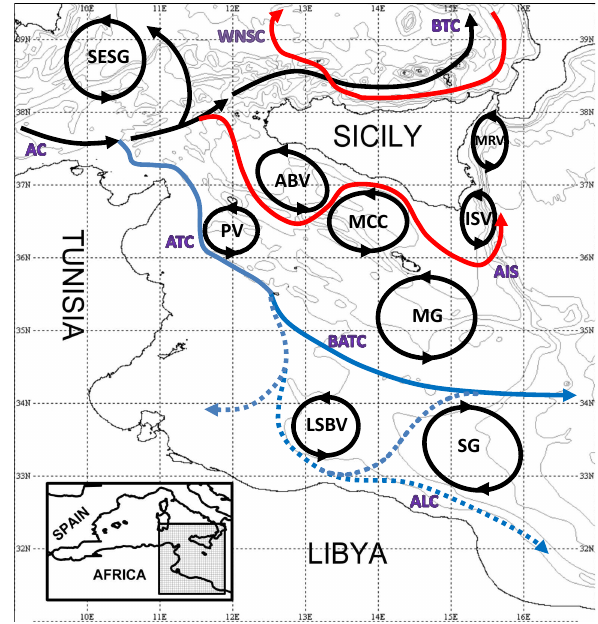
Fig. 2. Schematic surface circulation with cyclonic/anti-cyclonic features (modified from Lermusiaux and Robinson, 2001; B´eranger et al., 2004 and Hamad et al., 2005) togheter with new features found in the present work. Acronyms are listed in table 1. Permament features/paths are in black while seasonal are in red (summer) and in blue (winter). Continuous lines are for features from bibliography while dotted are for new ones.